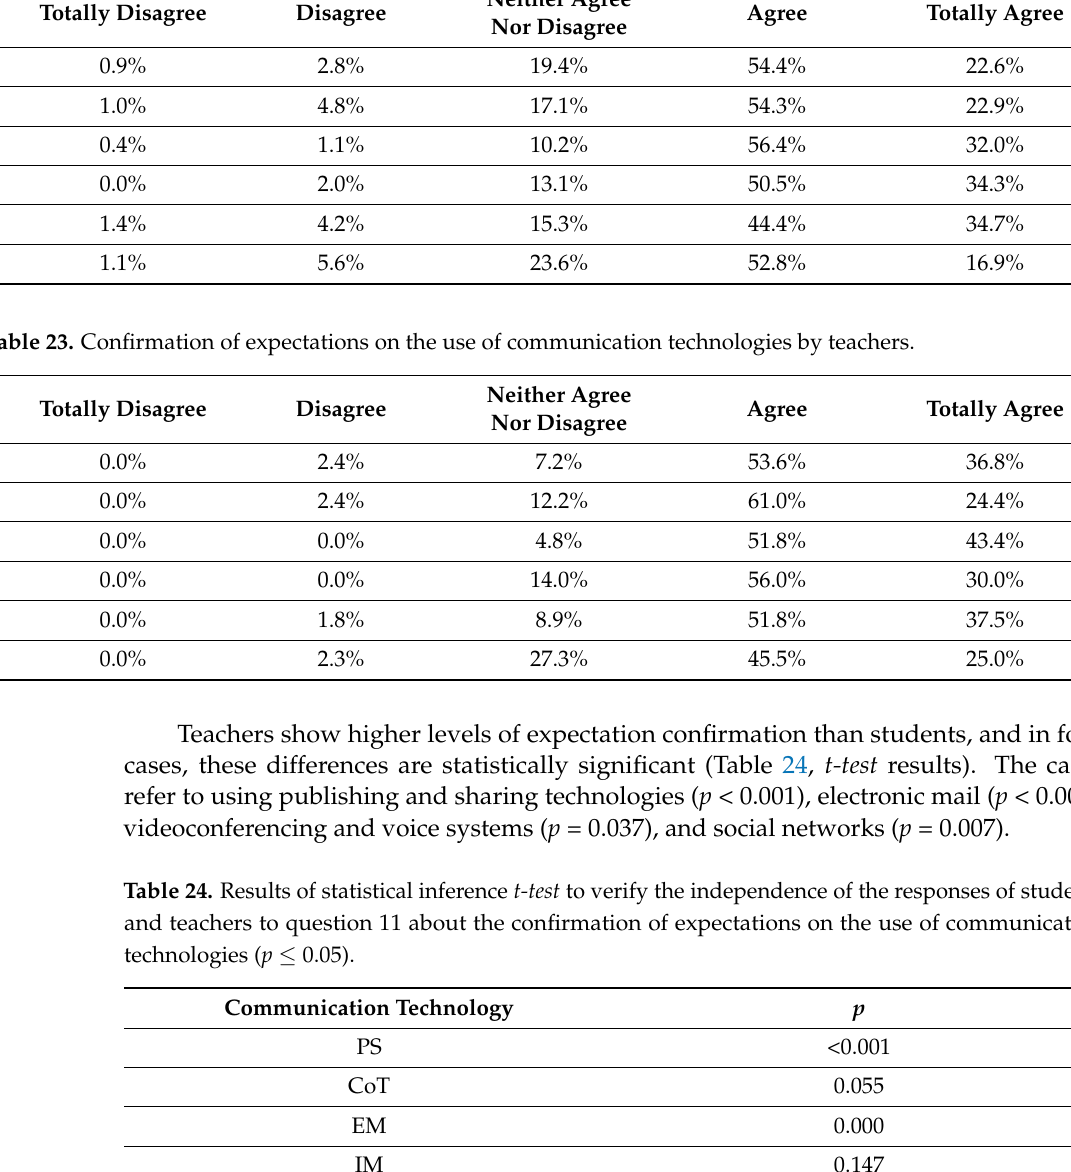
Table 22. Confirmation of expectations on the use of communication technologies by students. Communication